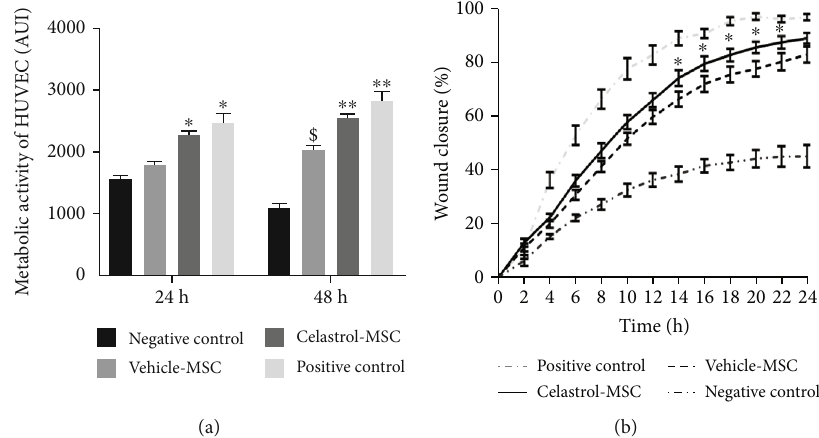
Figure 5: Celastrol preconditioning increases paracrine proangiogenic activity. (a) HUVEC growth when cocultured with hydrogel-encapsulated hMSC. Alpha MEM 0.2% FBS and EGM were used as negative and positive controls, respectively ( mean ± SEM , n ≥ 3 , N ≥ 2 ); ∗ p < 0 : 05 versus the vehicle at 24h; ∗∗ p < 0 : 05 versus the vehicle at 48h; $ p < 0 : 05 versus alpha MEM 0.2% FBS at 48h. (b) E ff ect of paracrine activity of hydrogel-encapsulated hMSC on wound closure; mean ± SEM , n ≥ 9 , N = 2 ; negative control: alpha MEM 0.2% FBS; positive control: EGM ( ∗ p < 0 : 05 versus the vehicle group at each time point).